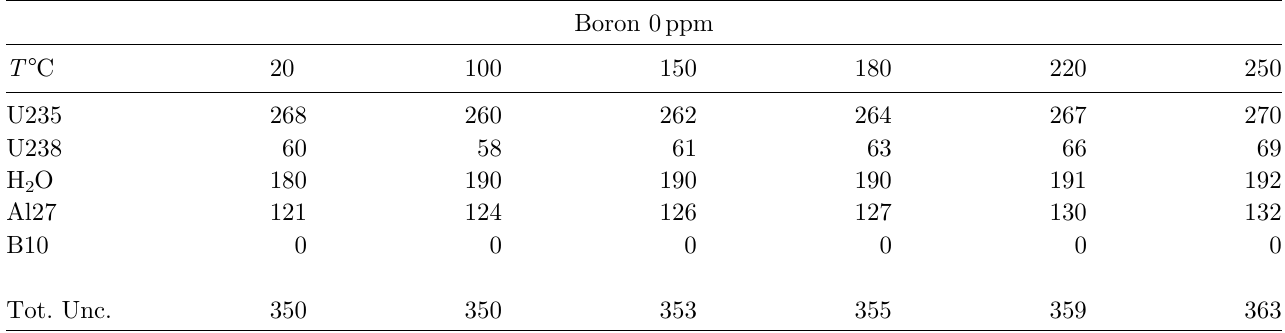
Table 2. Reactivity uncertainty as a function of the core temperature (pcm at 1 s